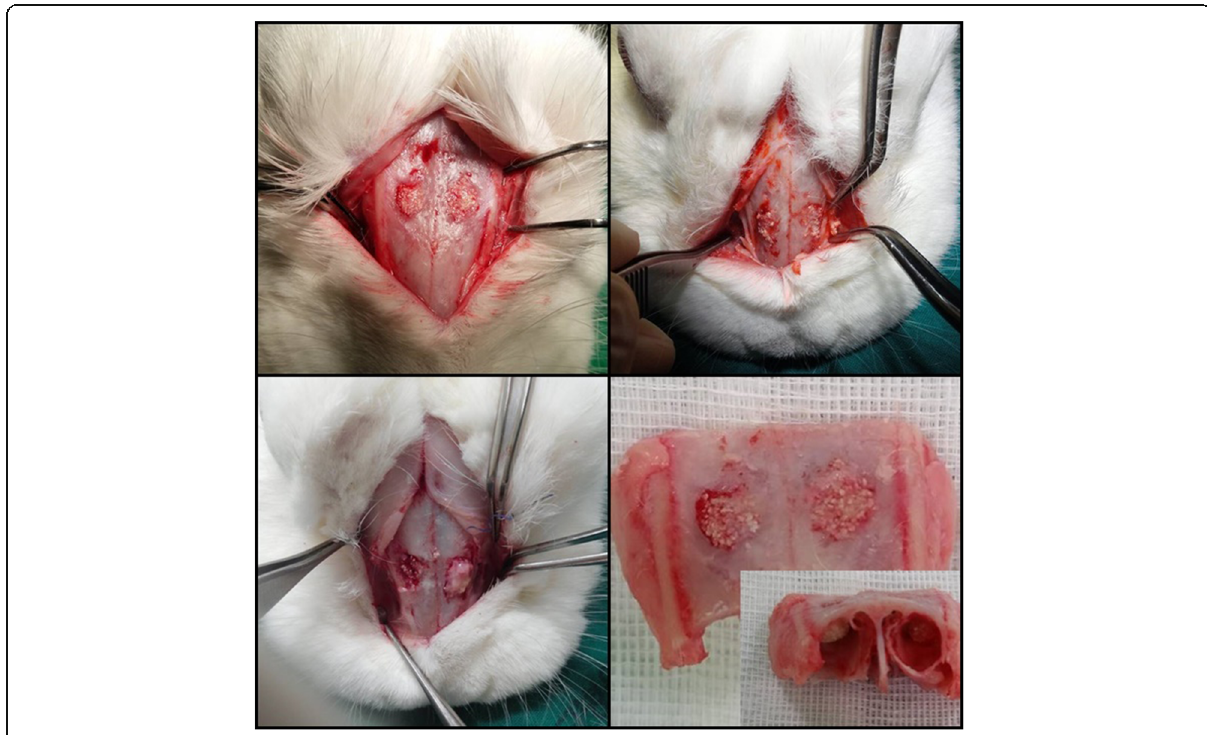
Fig. 2 Photograph of experiment after sampling. G 1, group 1, Bio-Oss®; G 2, group 2, Bio-Oss® mixed with